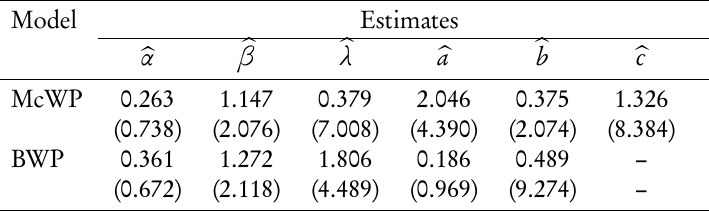
MLEs and their standard errors (in parenthesis) for waiting time